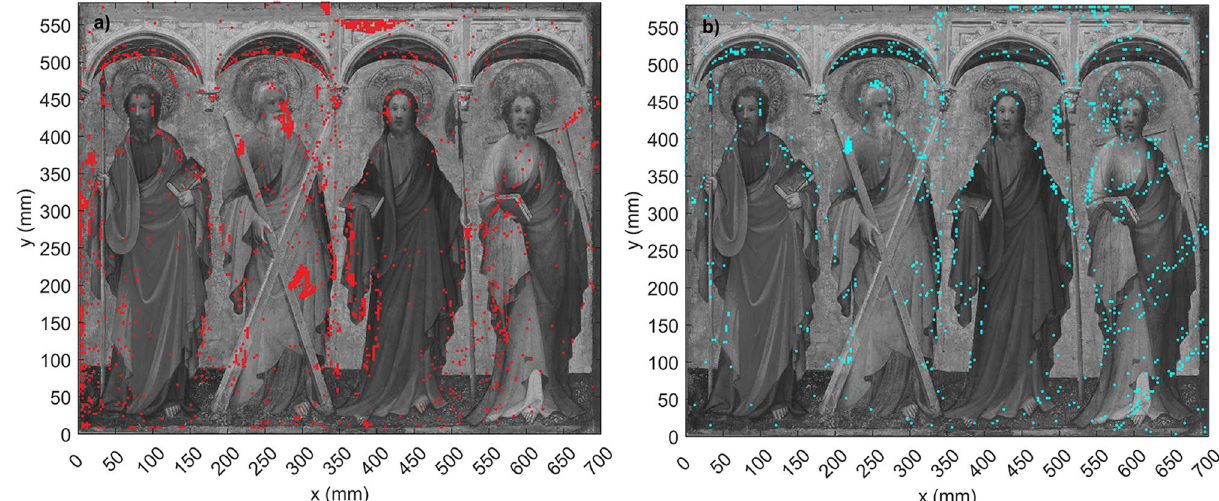
Figure 2. ( a ) Delamination mapping created with the THz data from before the consolidation effort plotted on top of a black and white photograph of the painting. ( b ) Delamination mapping after consolidation. Figure ( b ) shows significantly less areas that contain dense groups of markers, indicating the success of the consolidation